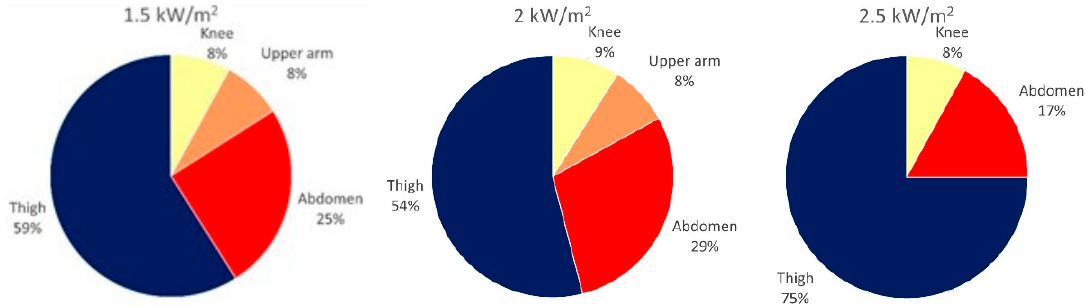
Figure 7. The ratio of skin locations with maximum skin temperatures.